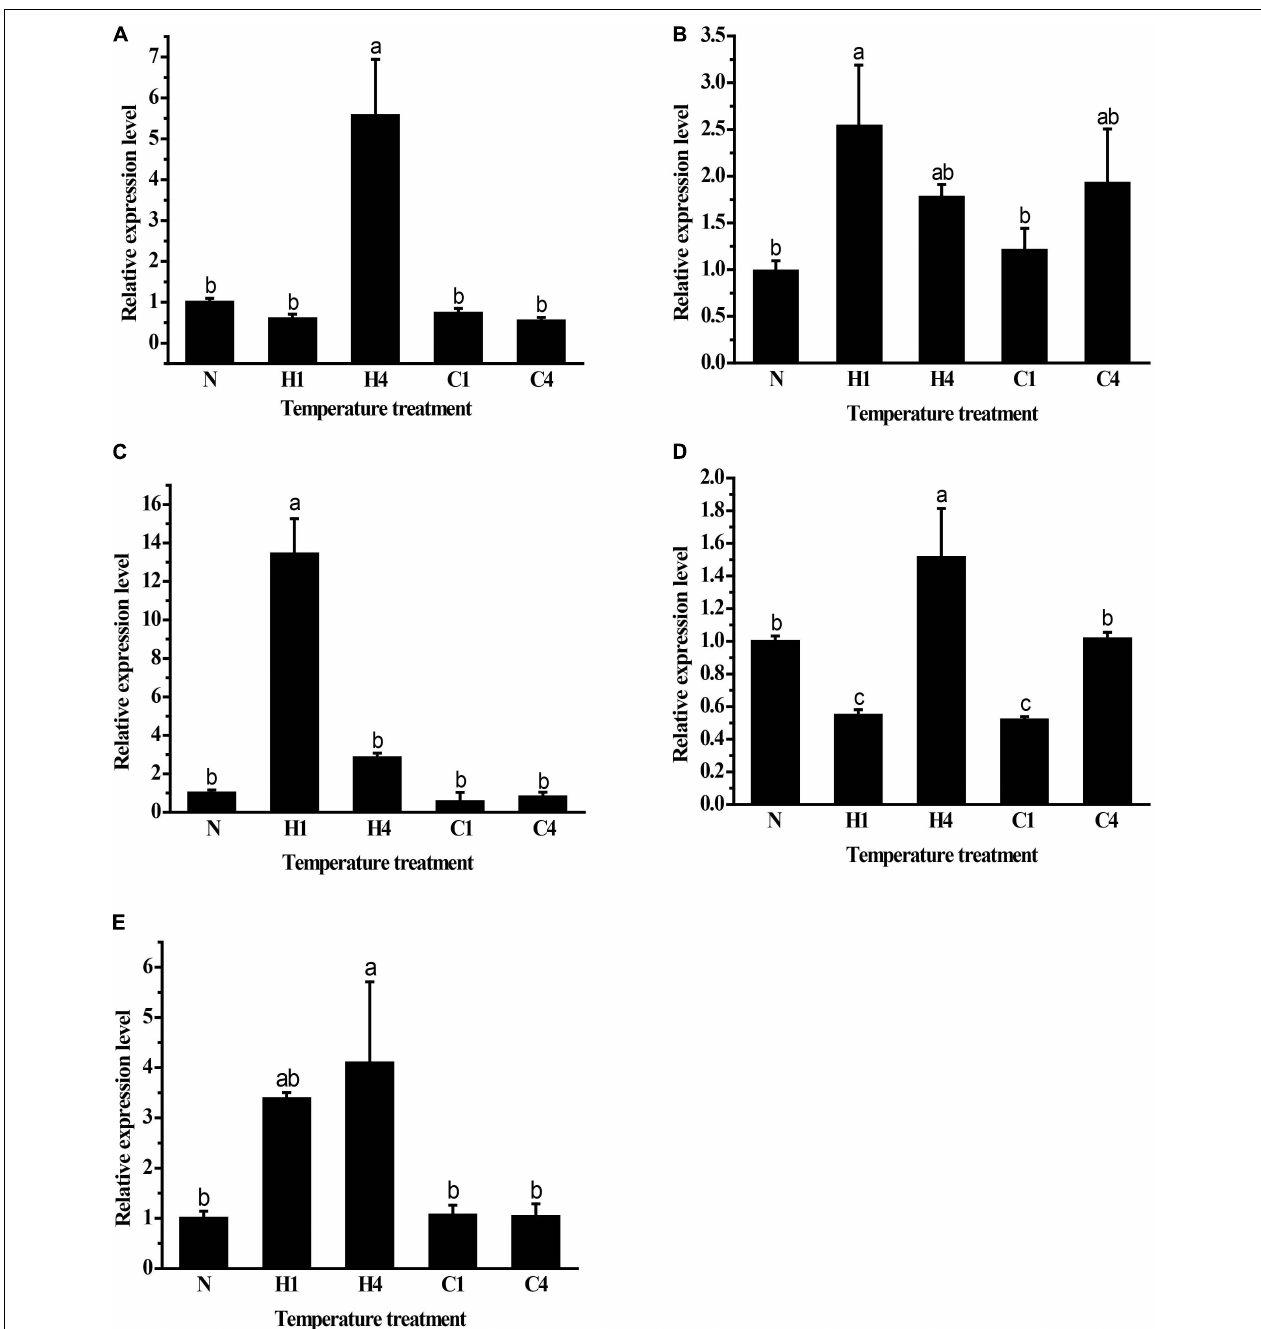
FIGURE 6 | Relative mRNA expression levels of GpHsps at extreme cold and heat temperature stress. (A) GpHsp71.3; (B) GpHsp74.9; (C) GpHsp82.4; (D) GpHsp89; (E) GpHsp93.4 .N: normal temperature control (25 ◦ C); H1: heat shock (40 ◦ C) for 1 h, H4: heat shock (40 ◦ C) for 4 h, C1: cold shock (0 ◦ C) for 1 h, C4: cold shock (0 ◦ C) for 4 h. Data are shown as the mean ± SE of three biological replicates. Differences among triple repeats were analyzed using one-way analysis of variance (Systat, Inc., Evanston, IL) with Tukey’s post hoc test. Different lowercase letters indicate significant differences ( p < 0.05).